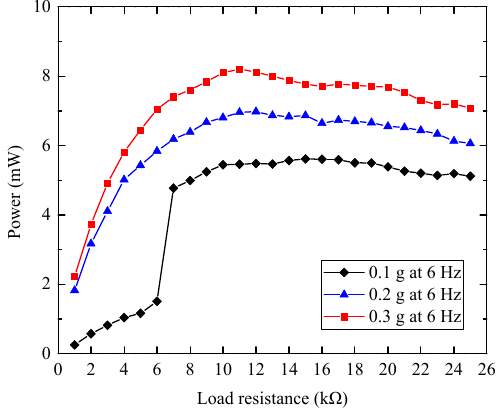
Figure 10. Output power versus load resistance under different base excitations.